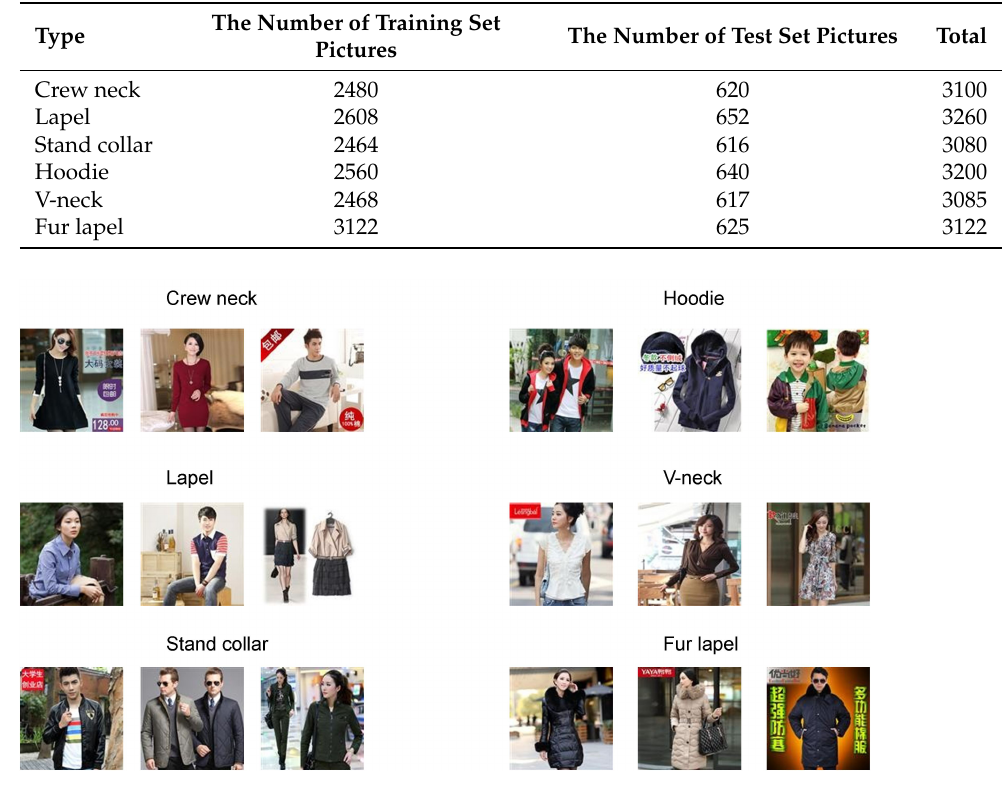
Figure 4. Data distribution for the Collar6 dataset.